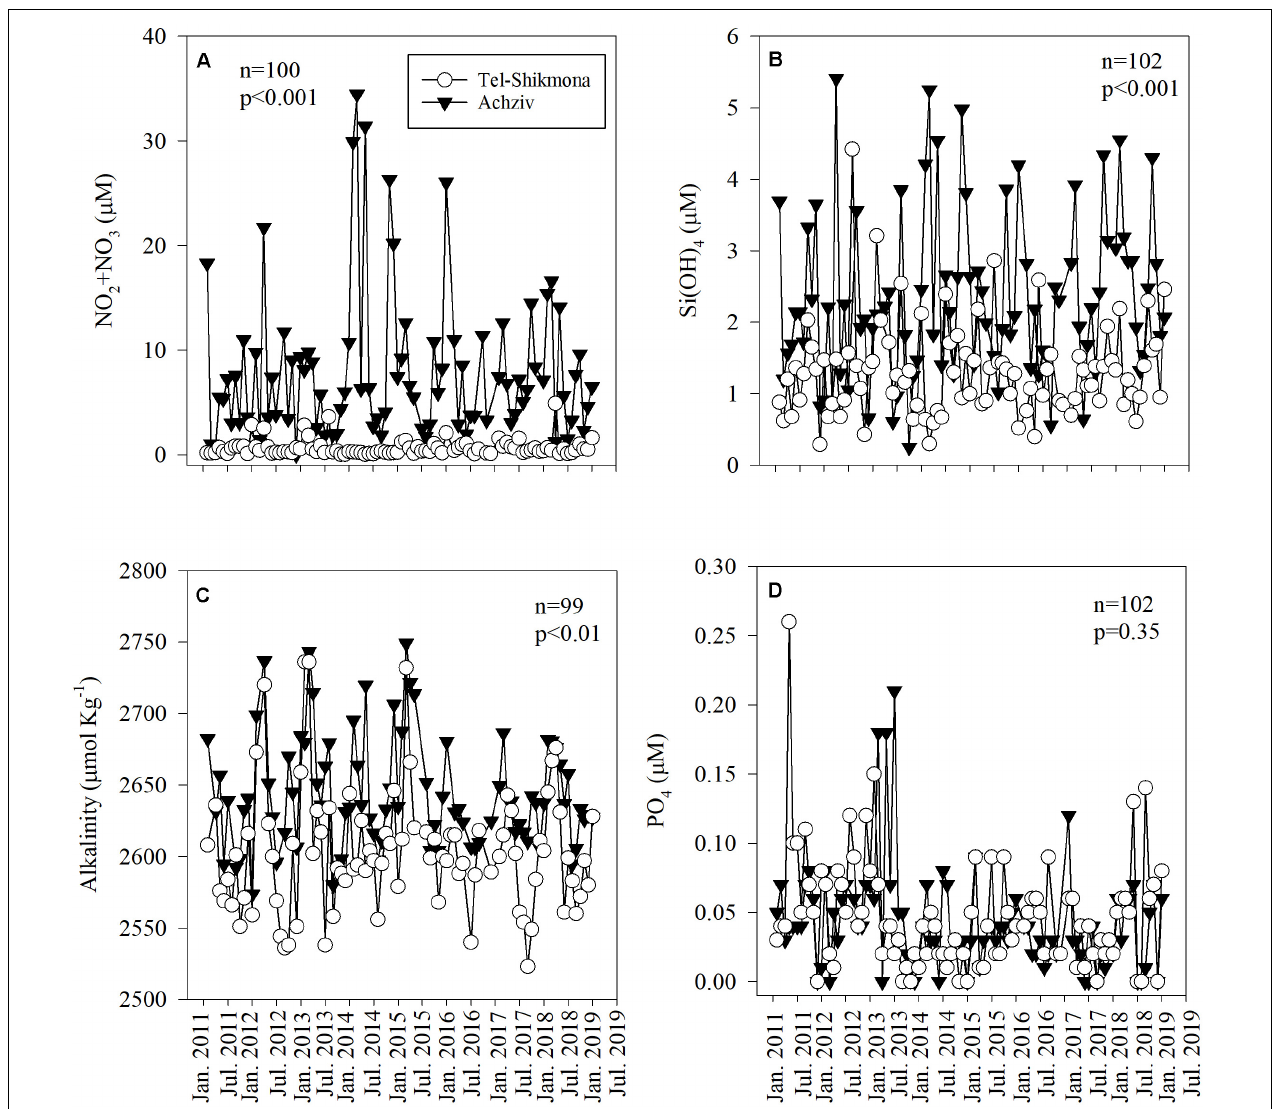
FIGURE 2 | The temporal variability of NO x (A) , Si(OH)4 (B) , total alkalinity normalized to a constant salinity of 39.234 PSU (multi annual average salinity measured at both sites) (C) , and PO 4 (D) collected by the Israeli National Monitoring Program in the surface water in Achziv (black triangle) and Tel Shikmona (white circle) during the period